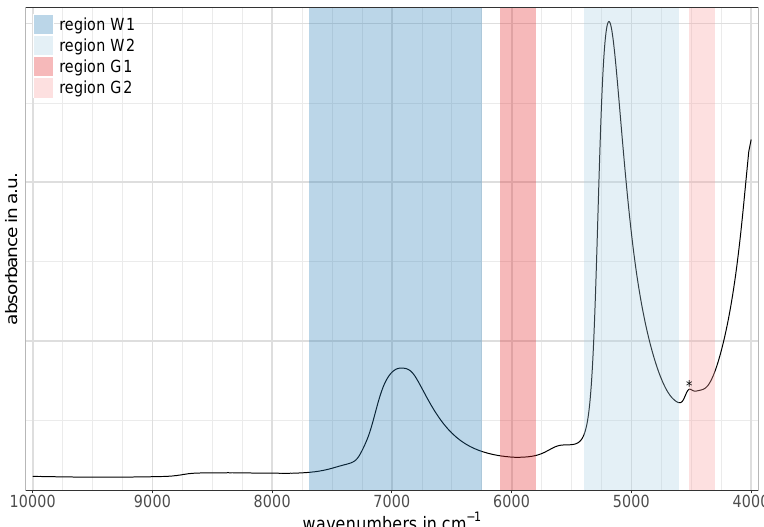
Figure 1. Illustration of the division of the spectral regions W1, W2, G1, and G2 using an exemplary spectrum collected with the 0.1 mm cell. The O − H residue in the cell’s quartz windows at around 4500 cm − 1 is marked with an asterisk. It is assigned to a combination of an O − H stretching vibration and one of the SiO fundamental vibrations 2